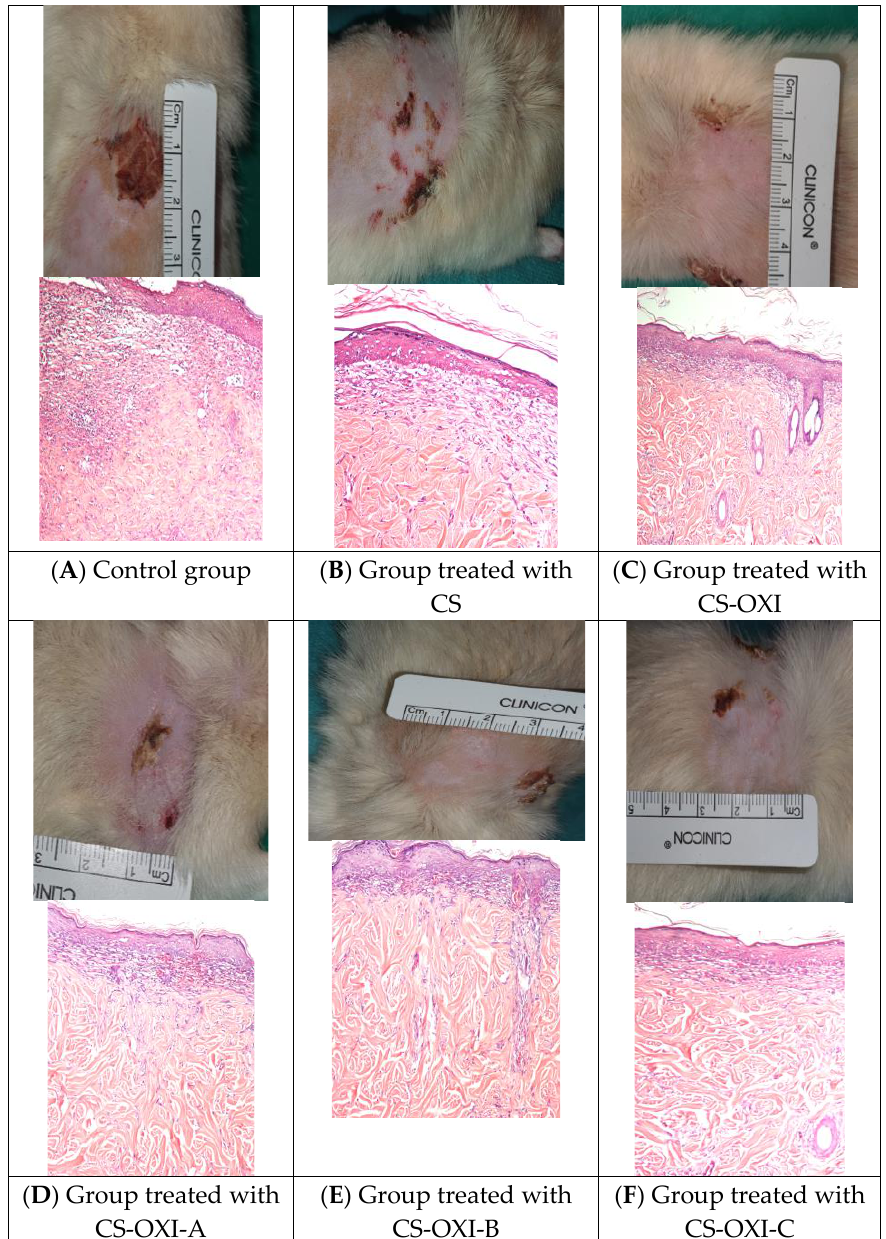
Figure 8. Microscopic and macroscopic images of burn wound at 14 days. ( A ) Control group; ( B ) Group treated with CS; ( C ) Group treated with; CS-OXI; ( D ) Group treated with CS-OXI-A; ( E ) Group treated with CS-OXI-B; ( F ) Group treated with CS-OXI-C. The macroscopic exam of burns revealed the process of healing and the size of burns reported at two different moments of the experiment. The wound closure percentage of burn surface areas at different days during the recovery phase is shown in Figure 9. In correlation with the in vitro antimicrobial activity, where the OXI-B compound proved to be the most active, in the in vivo test, the CS-OXI-B membrane determined (from the fifth day) the greater reduction of the burn-affected surface area. On the other hand, the